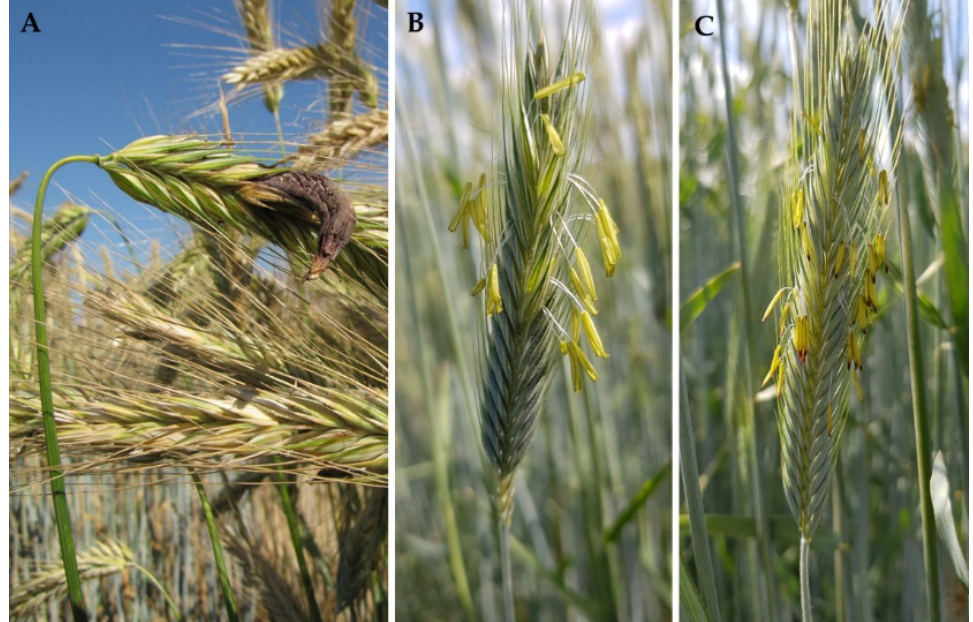
Figure 5. ( A ) C. purpurea infects the ovary and replaces the rye grain with a dark fungal body, the ergot sclerotium. ( B ) The gene Rfp1 results in restoration of male fertility in P-type CMS rye hybrids and increases ergot defense. ( C ) Male sterile plants in P-type CMS rye hybrids with a restorer index of ~50% increase yield potential due to a female advantage but weaken the ergot